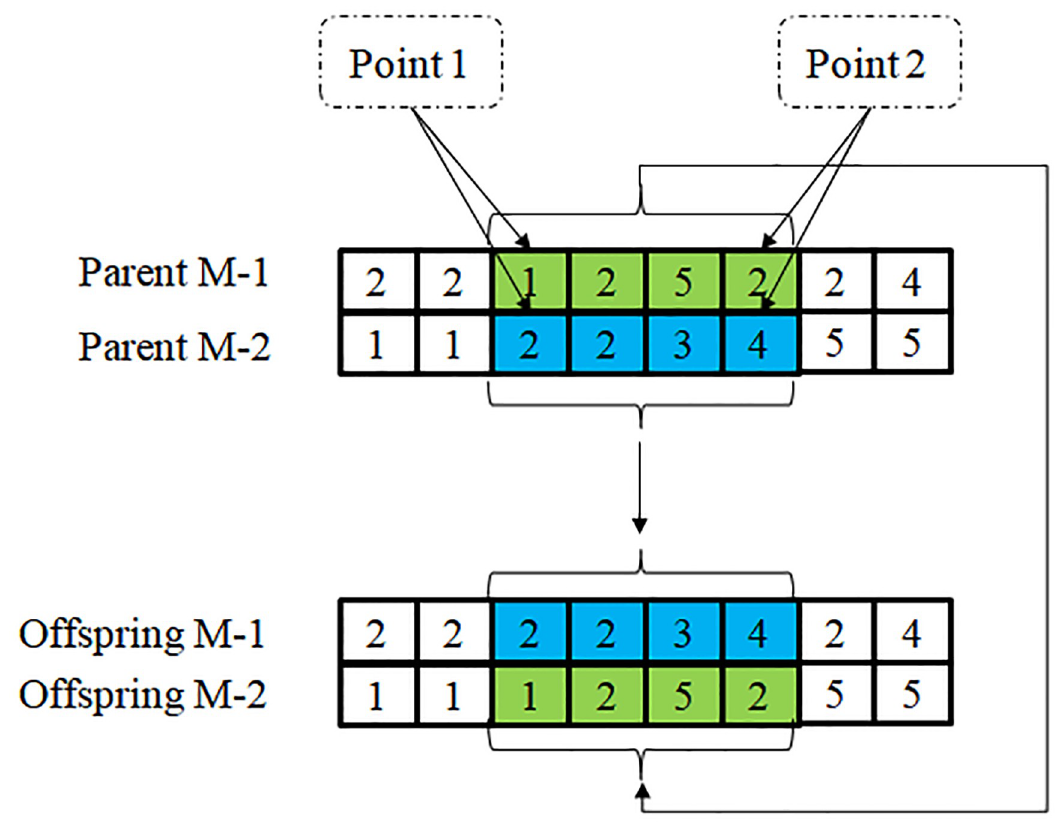
Fig 3. Schematic diagram of two-point crossover.